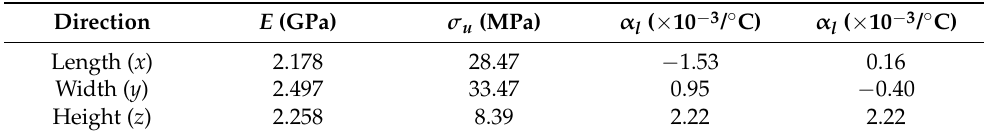
Table 1. Directional elastic moduli ( E ), tensile strengths ( σ u ), and apparent thermal expansion coefficients of additively manufactured specimens.